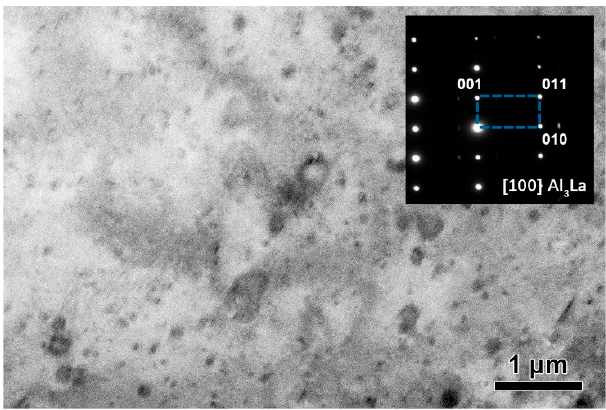
Figure 4. The XRD analysis results of AZ91 and AZ91-La alloys.